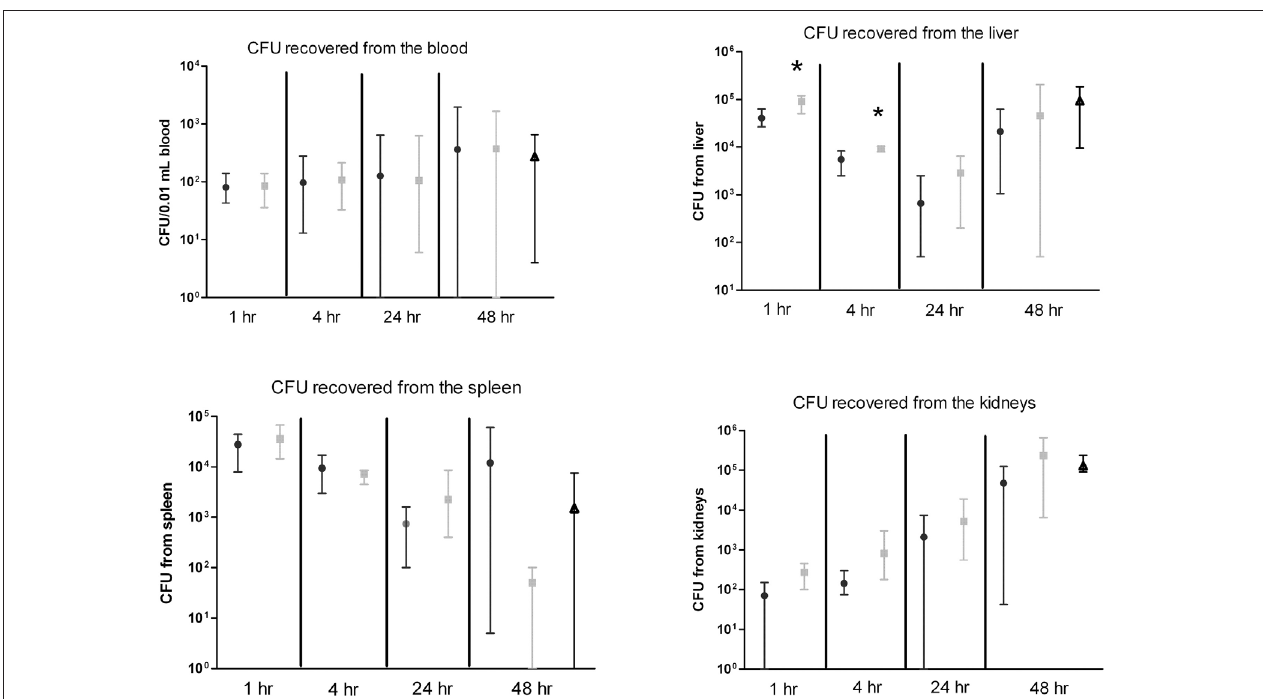
FIGURE 5 | Bacteria burden in murine tissue post immunization and challenge with S. aureus. Balb/c mice were passively immunized with CS-D7 (circles) or isotype control 20C2HA (squares) or PBS alone (triangles), and 2h later were challenged via the tail vein with S. aureus SA025. At designated time points, subsets of animals were sacrificed and the blood and